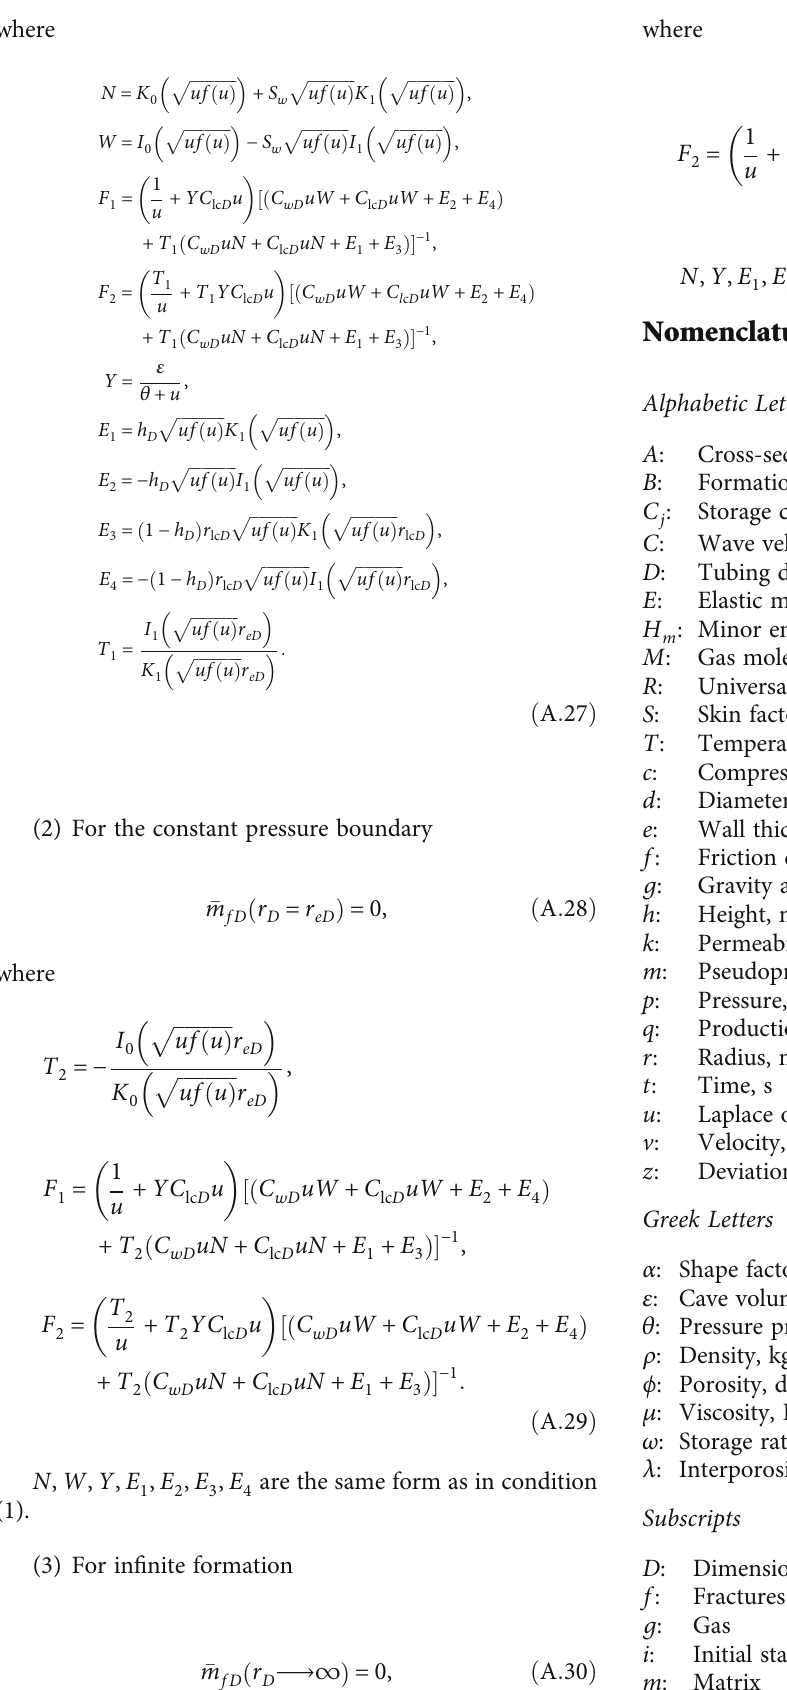
p(cid:9) uf u ð Þ